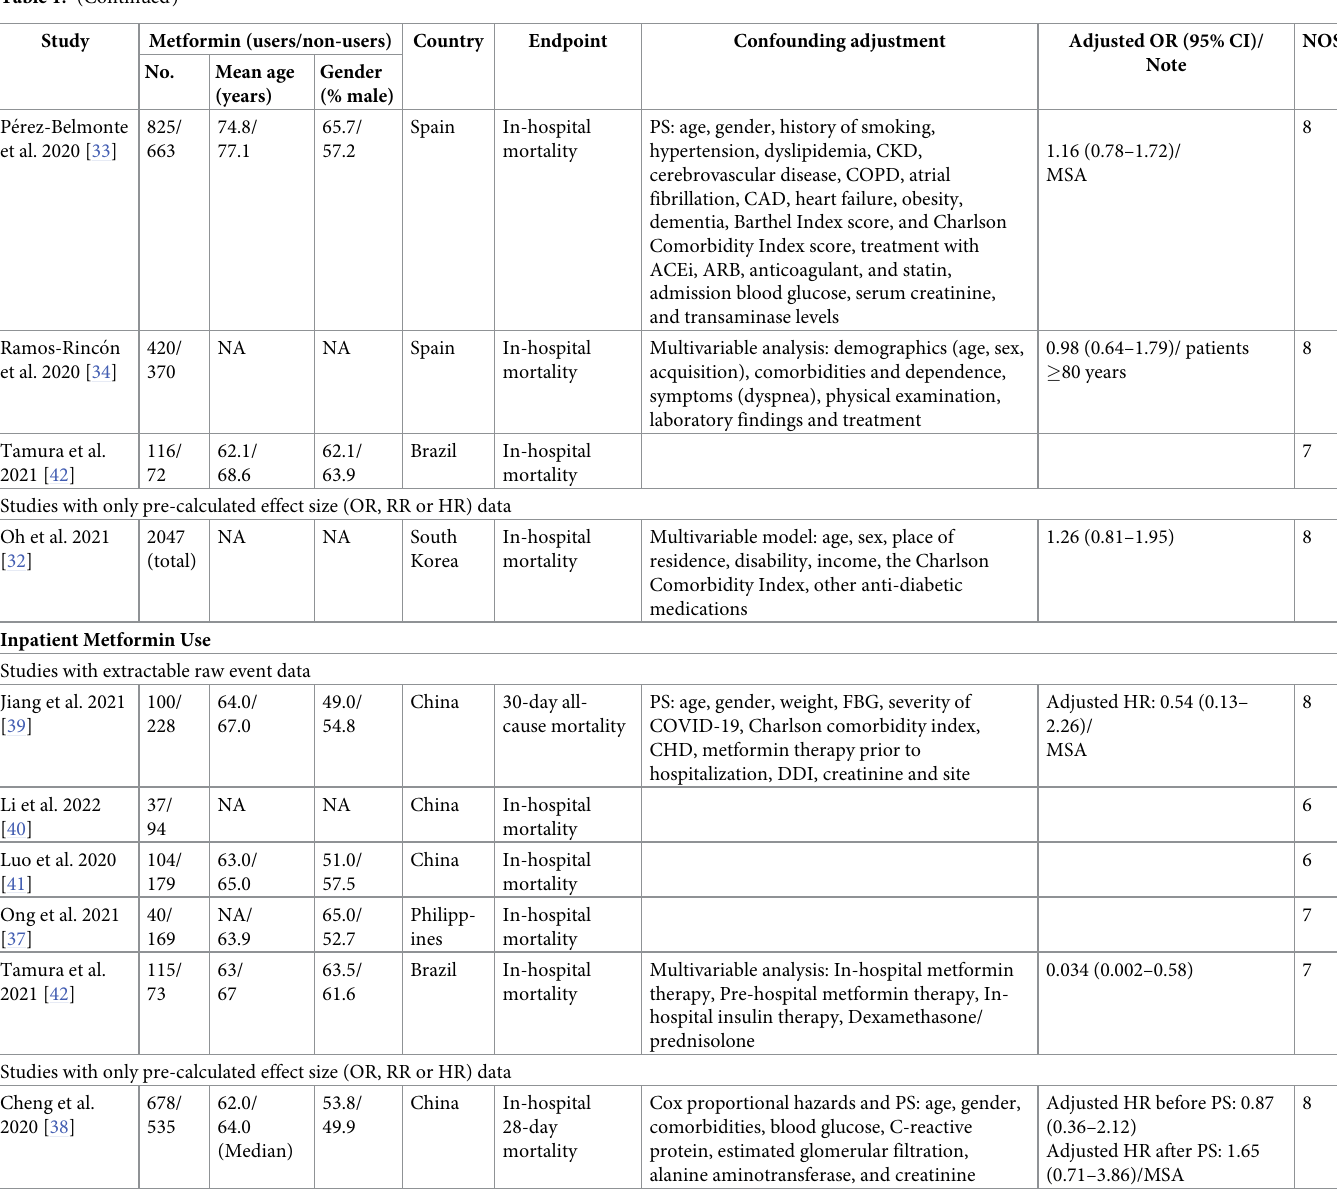
analysis using two approaches. First, meta-analysis of 16 studies with extractable raw event data from 30,891 metformin and 25,770 non-metformin users revealed that outpatient metfor- min use was associated with a significant reduction of in-hospital death (Fig 2A) with a pooled unadjusted OR of 0.48 (95% CI, 0.37–0.62; I 2 = 87%). Publication bias was assessed using